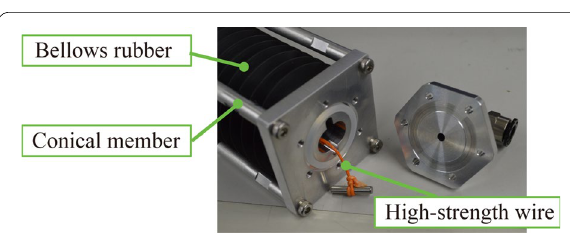
Fig. 10 Thin ring member insertion and assembly procedure for improving contraction force of the bellows pneumatic actuator